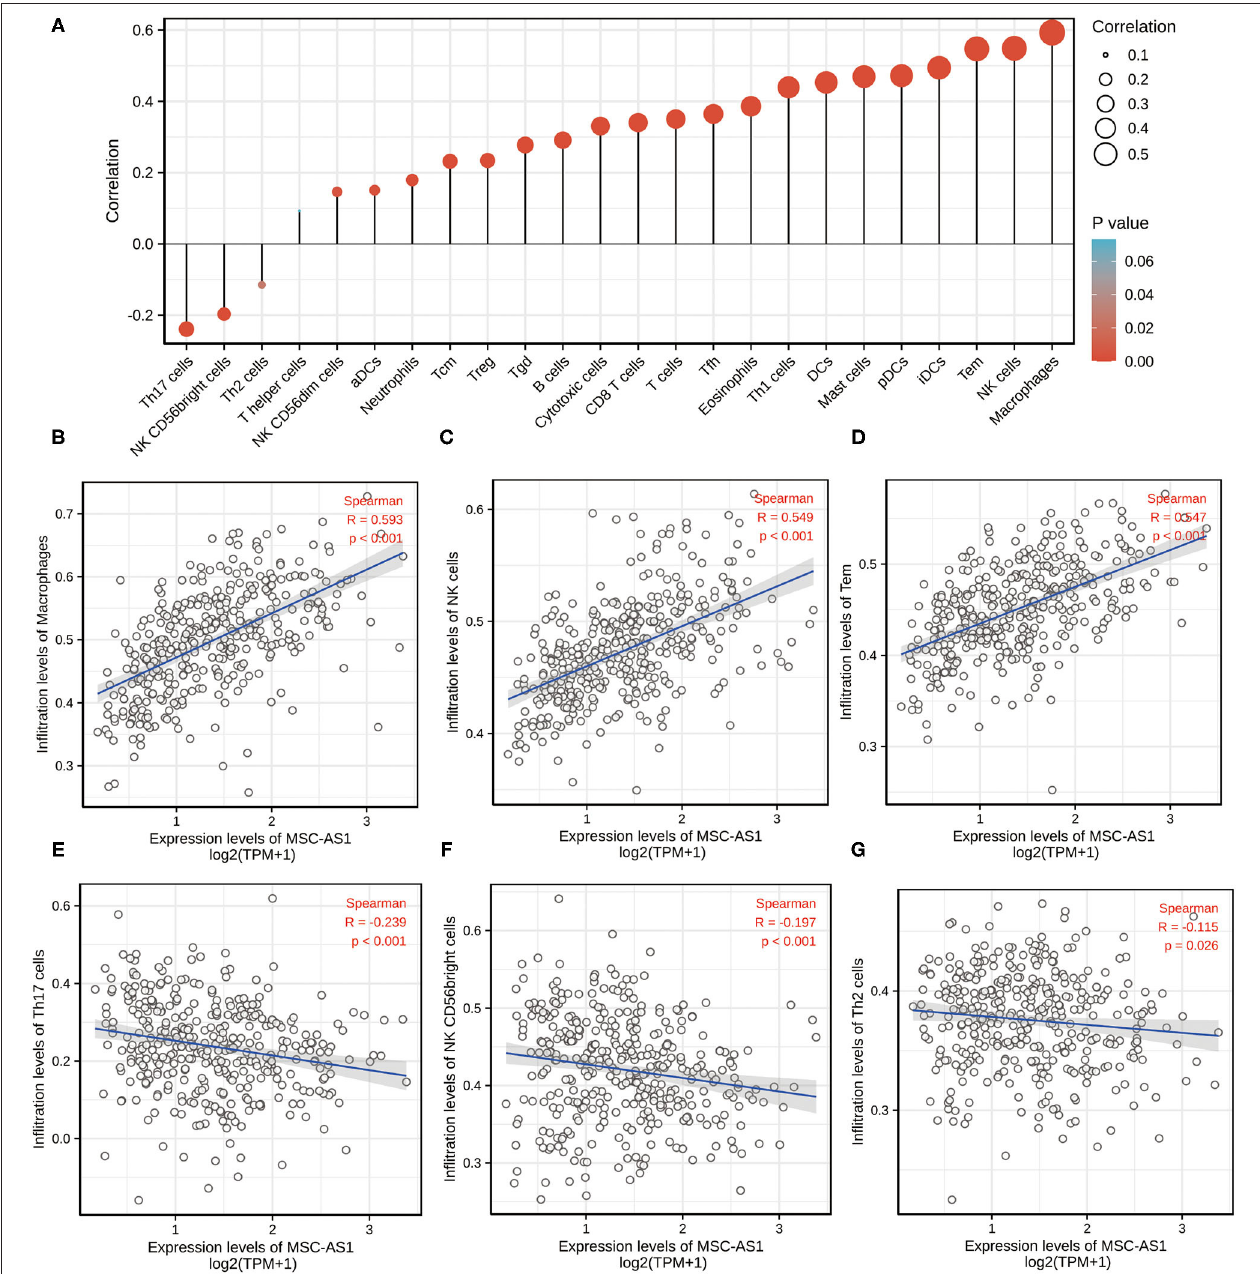
FIGURE 3 | The expression level of long non-coding RNA (lncRNA) MSC-AS1 was associated with immune infiltration in the tumor microenvironment. (A) Correlation between the relative abundances of 24 immune cells and lncRNA MSC-AS1 expression level. The size of dots shows the absolute value of Spearman. Correlation between the relative enrichment score of Macrophages (B) , NK cells (C) , Tem (T effector memory) (D) , Th17 cells (E) , NK CD56bright cells (F) , Th2 cells (G) and the expression level (TPM) of lncRNA MSC-AS1.